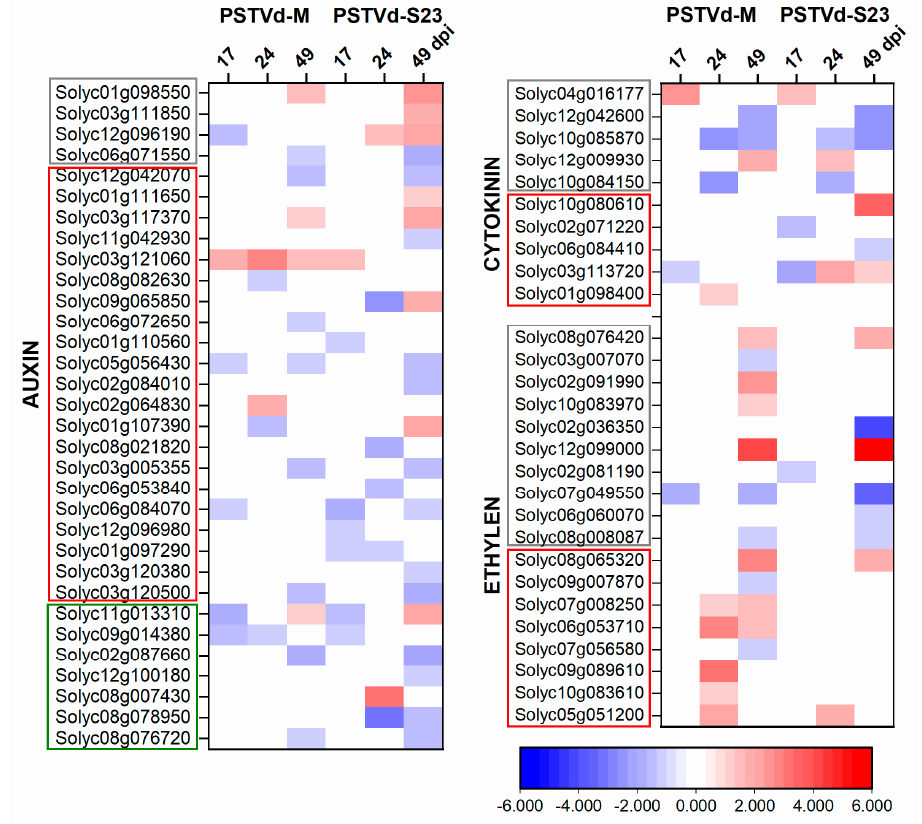
Figure 4. Heat map of log 2 FC of DEGs related to plant hormones. DEGs involved in biosynthesis, signaling and transport are in grey, red, and green frames, respectively.